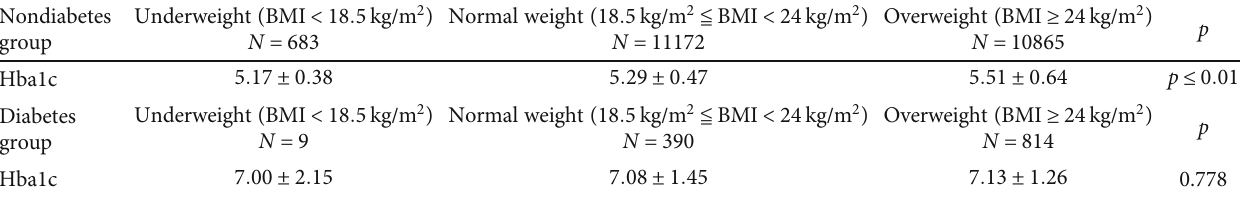
Table 3: Correlation between HbA1c and body weight.